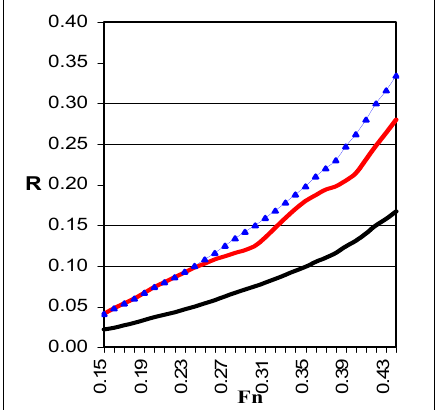
Figure 4. Experiment with the tandem struts. Fn is determined by the distance between the bow perpendiculars of the struts; the lower curve—R residual resistance of one strut, the upper curve—R of the twice the resistance of one strut; the red curve—R of the tandem of struts. The forward motion with a blunt end.